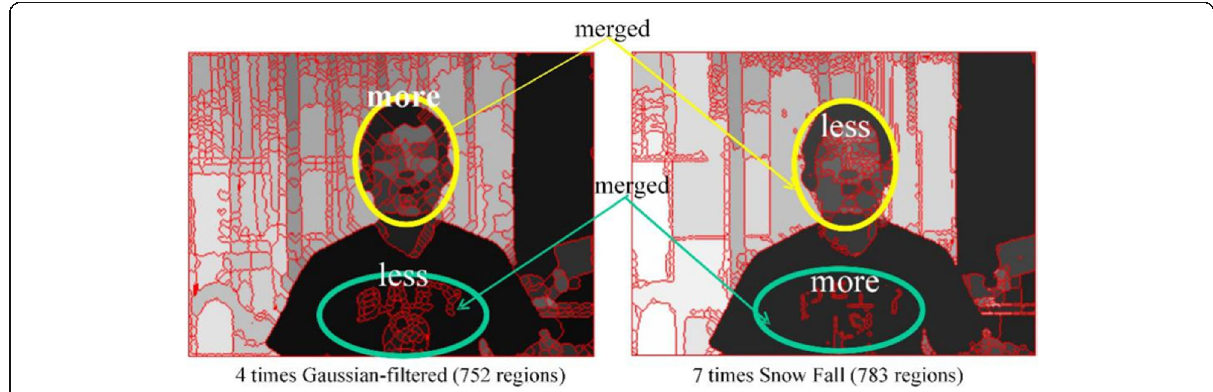
Fig. 11 Results of image edge information